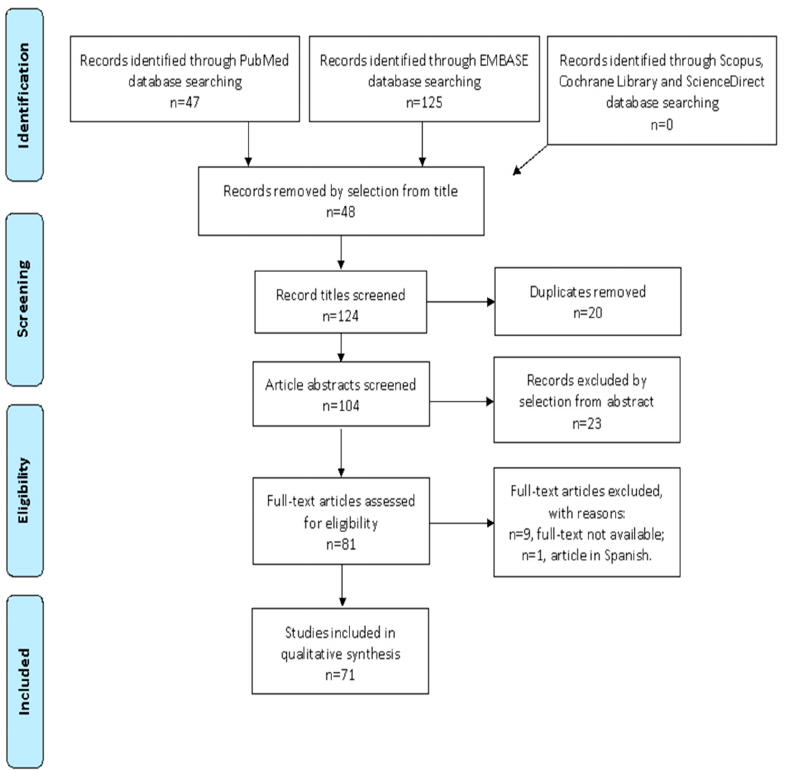
Figure 1. PRISMA (Preferred Reporting Items for Systematic Reviews and Meta-Analyses) Flow- chart. Table 1. Characteristics of included studies.